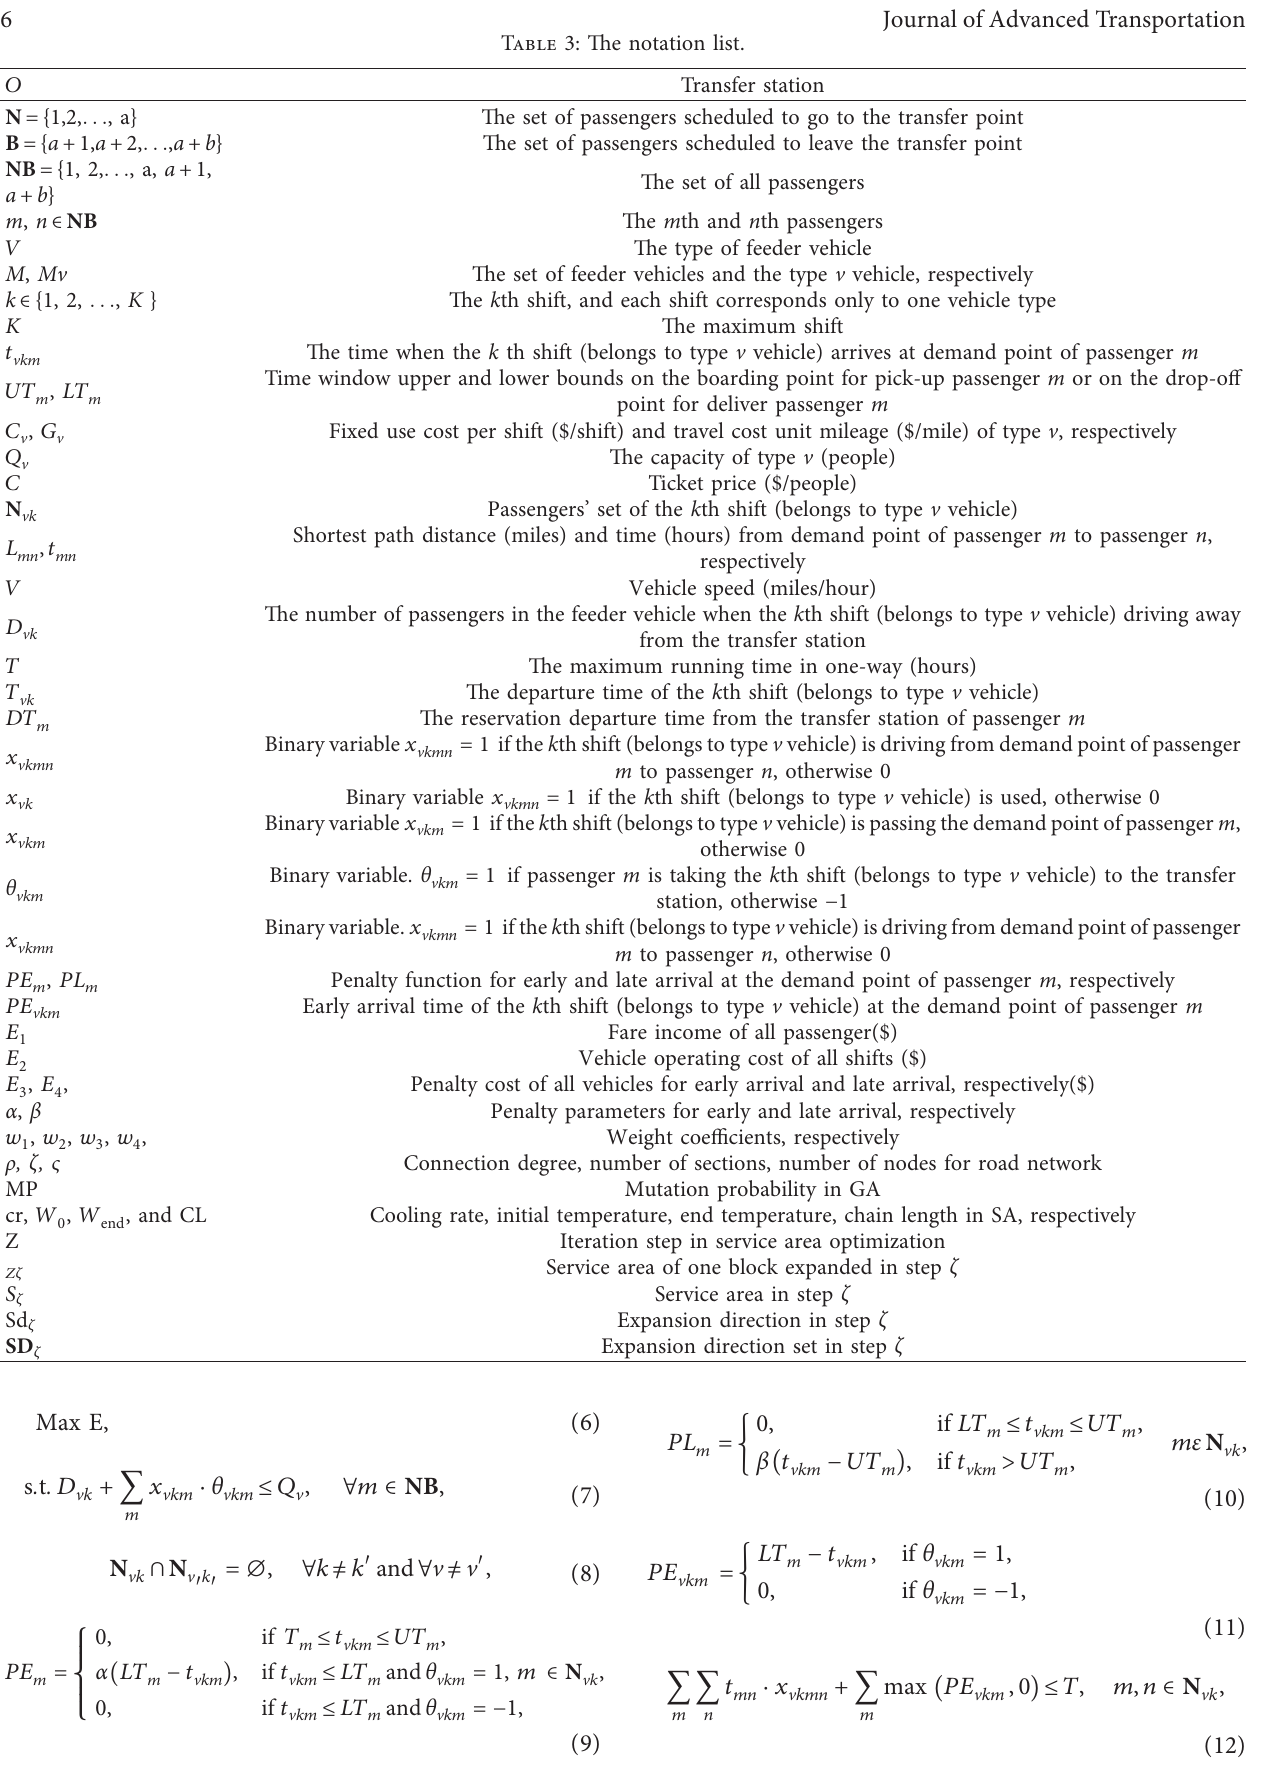
Table 3: The notation